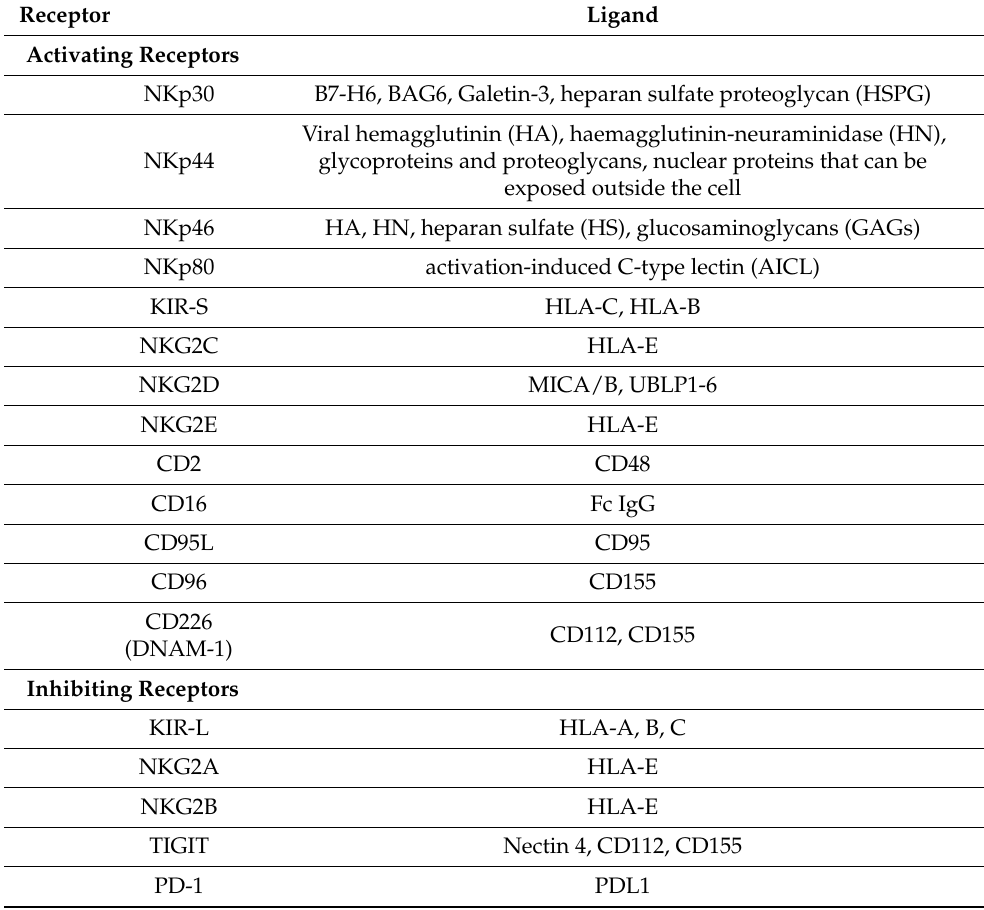
Table 1. Ligands of human NK cell